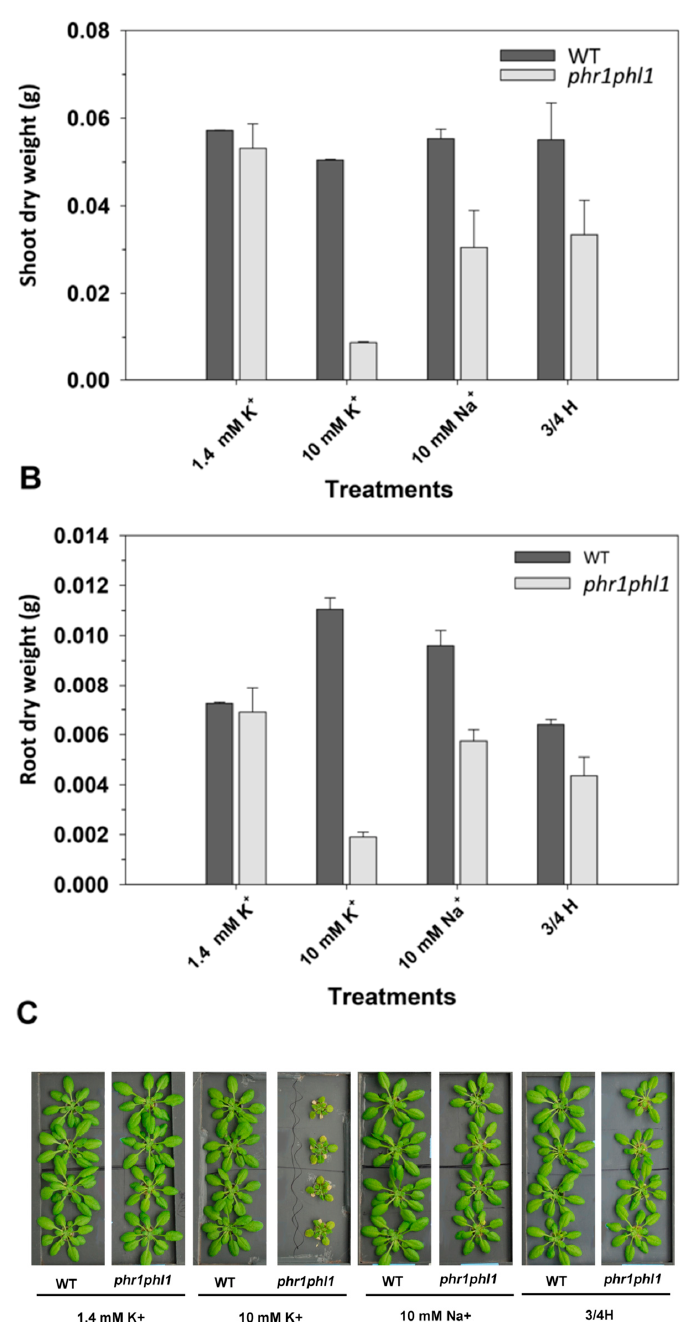
Figure 1. Shoot and root dry weights of plants exposed to 1.4 KCl, 10 mM KCl, 10 mM NaCl, and a concentrated nutrient solution. Plants of WT (dark grey bars) and phr1phl1 mutant (light grey bars) were grown for 33 days in 1 / 5 Hoagland control solution and then for 7 days in the presence of 1.4 mM KCl, 10 mM KCl, 10 mM NaCl, and a nutrient concentrated solution (3 / 4 Hoagland). Plants were separated in shoot and roots, dried at 65 ◦ C, and the dry weights were determined. Shown are average values of shoot ( A ) and roots ( B ) dry weights of three repetitions and errors bars denoted standard error. ANOVA was used to study the e ff ects of the treatment (T), the genotype (G), and their interaction (TxG), resulting in: T = *, G = *** and TxG = ***. Bars with di ff erent letters within lines denote significant di ff erences according to Tukey test (uppercase letters for WT and lowercase letters for phr1phl1 line). Di ff erences between genotypes within the same treatment were analyzed according to ANOVA. ***, **, * indicate significant di ff erences at p < 0.001, 0.01 and 0.05 respectively and n.s. indicates non-significant at p > 0.05. ( C ) Picture of plants exposed to the described